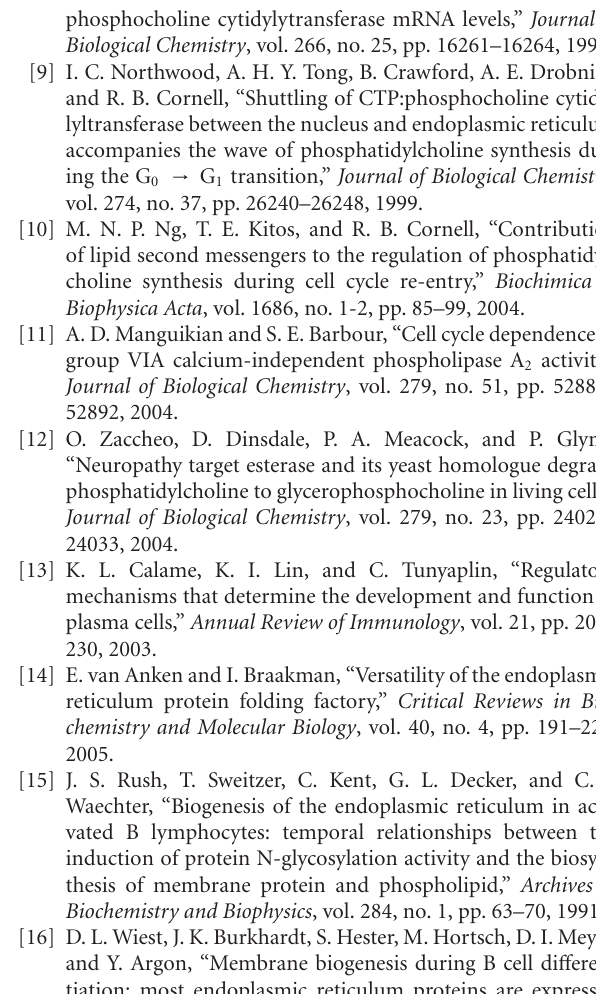
a metabolic cue for induction of the IRE1/XBP1 pathway